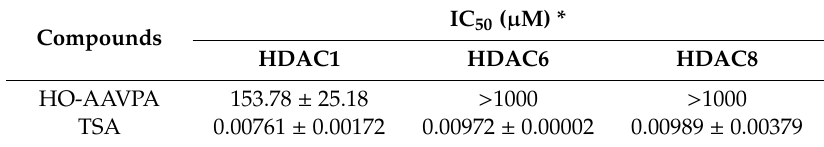
Figure 2. HDAC1 inhibition by HO-AAVPA. The inhibitory effect observed for HDAC1 with HO-AAVPA was dependent of the concentration. The values shown are the means of the % activity ± SE of duplicate measurements from two independent experiments. The significant difference is showed by * p < 0.05 obtained from one-way ANOVA test with Dunnett post-test. Table 2. IC 50 values of HO-AAVPA on HDAC1, HDAC6, and HDAC8.